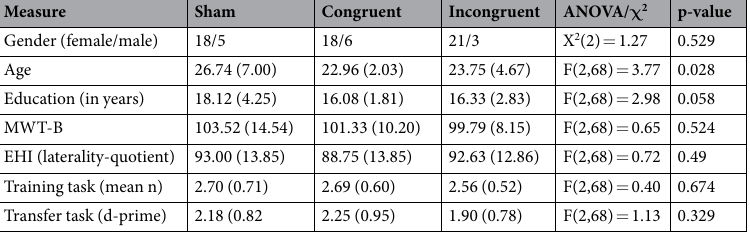
Table 3. Sample descriptive data and baseline comparisons between groups. Data are mean values with standard deviations in parentheses; EHI = Edinburgh Handedness Inventory; MWT-B = Multiple Choice Word Test-B.